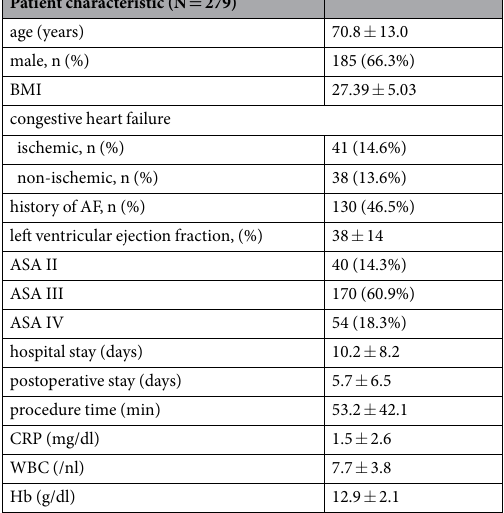
Table 1. Baseline demographics: clinical data and characteristics. AF, atrial fibrillation; ASA, American Society of Anesthesiologists; BMI, body mass index; CRP, c-reactive protein; Hb, haemoglobin; WBC, white blood